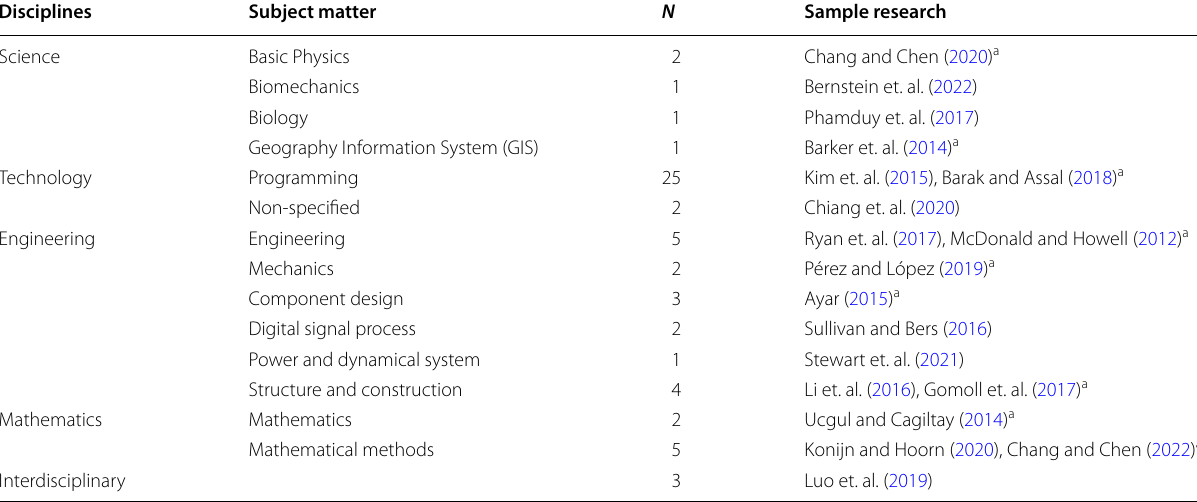
a Some articles were focused on cross-subject matters or disciplines